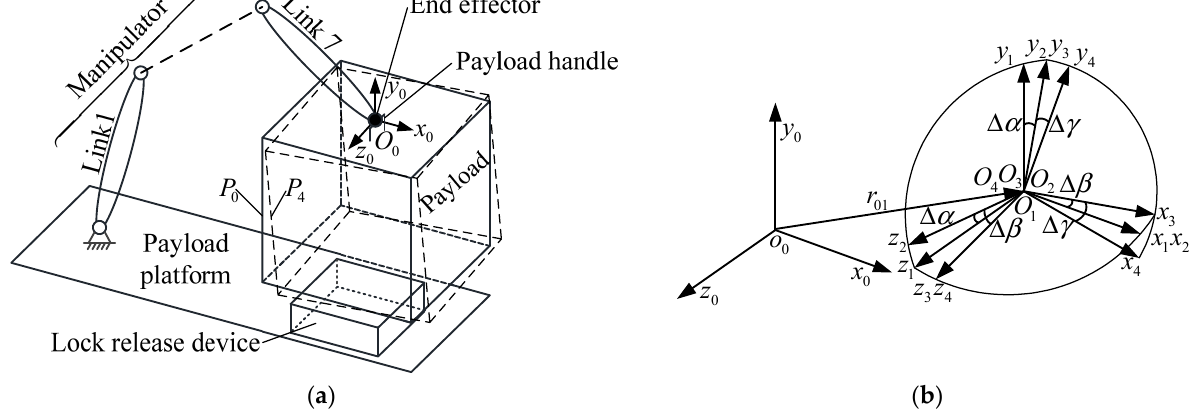
Figure 2. Schematic diagram of the position and attitude error working conditions for the capture and lock system. ( a ) Working conditions of the capture and lock system; ( b ) schematic diagram of load pose error.